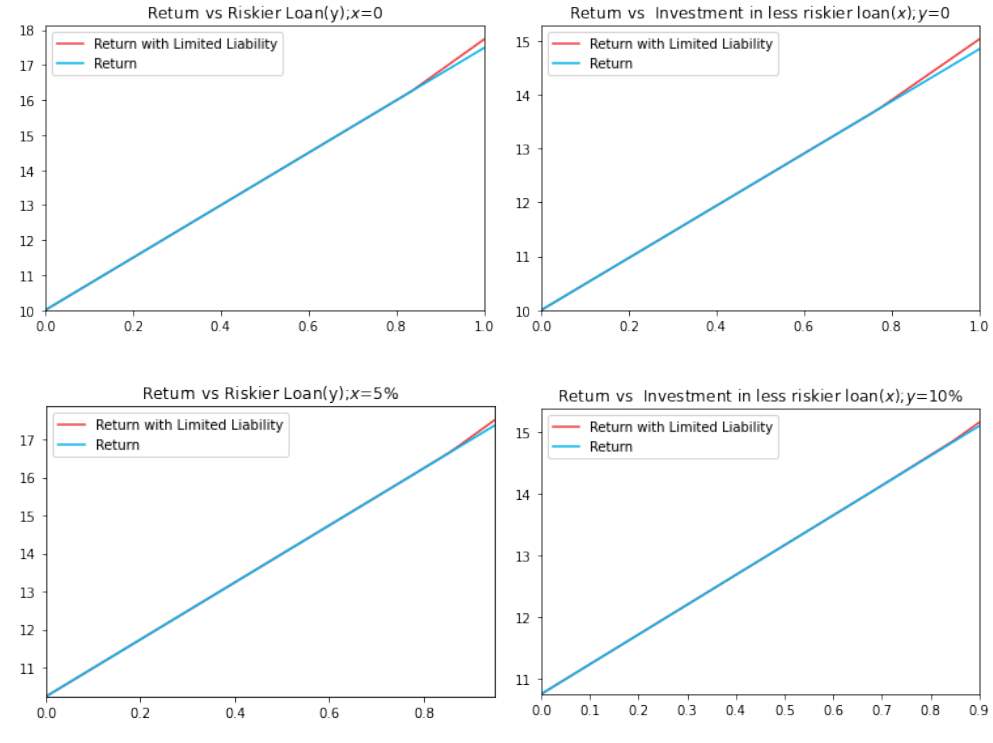
Figure 5. Expected Returns versus risky loans keeping the Leverage Ratio at